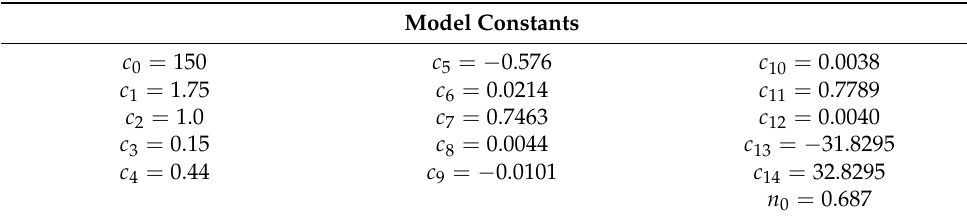
Table 2. Default model constants for EMMS model used in Barracuda ® 17.0.